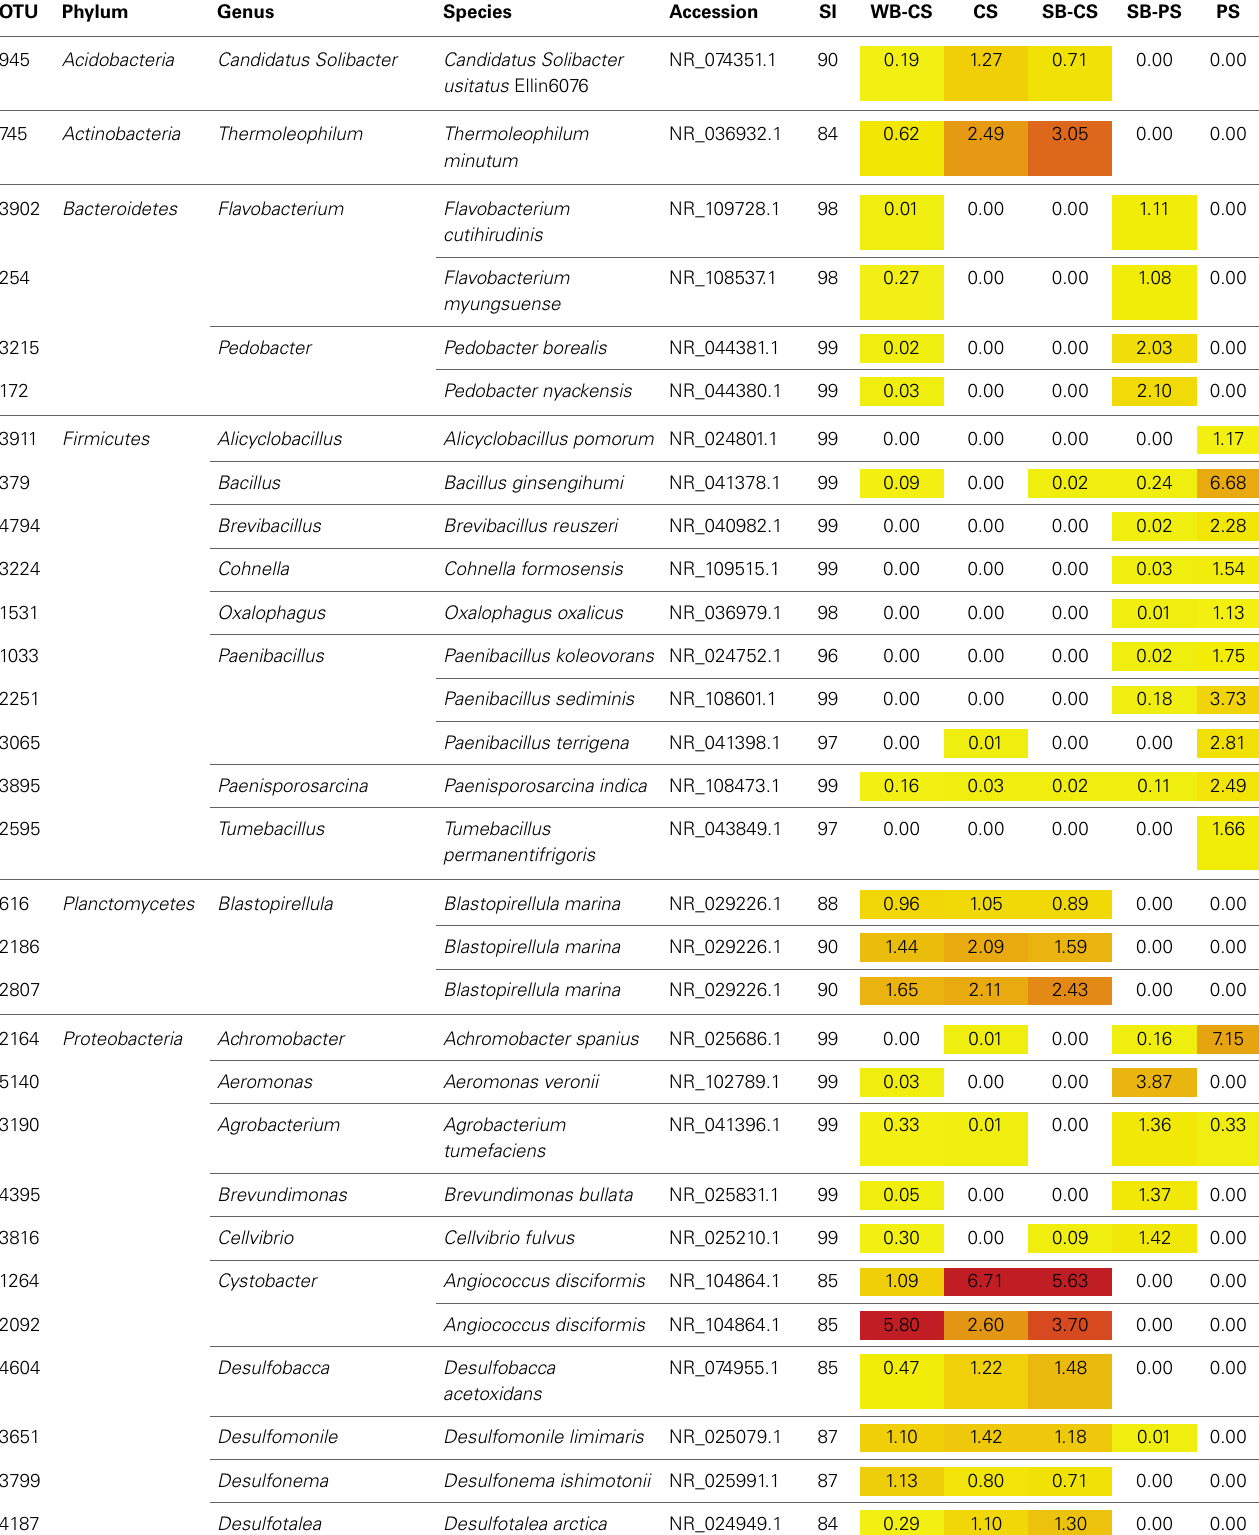
Table 2 | Taxonomic classification and relative abundance of dominant OTUs (cut-off level: 1%) from rhizosphere and soil samples. OTU